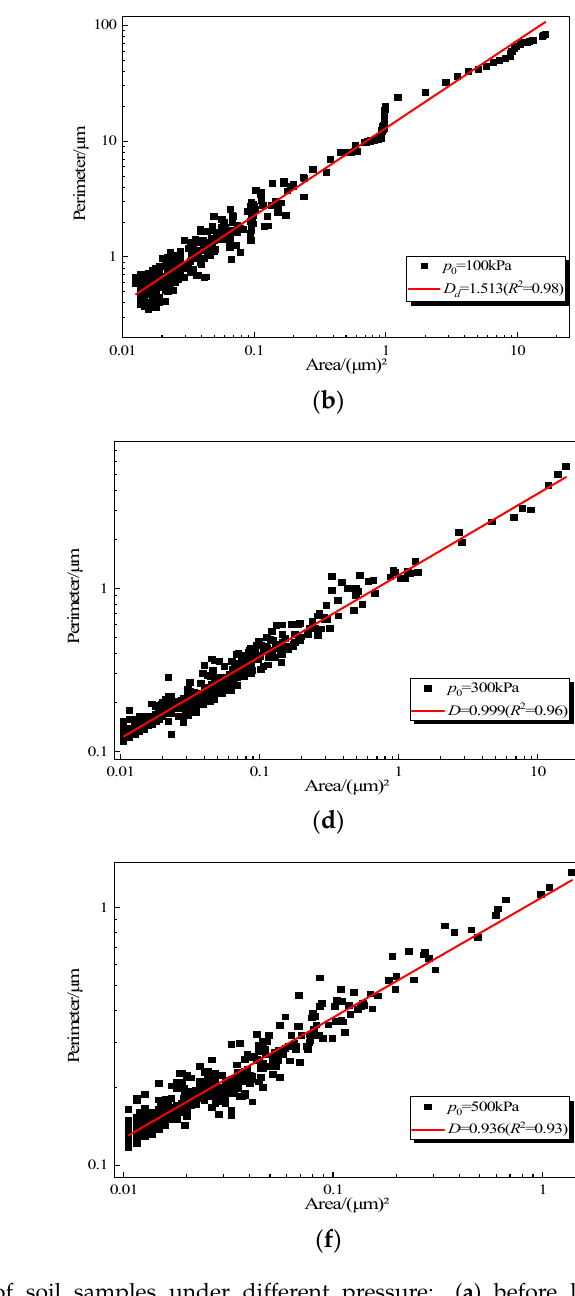
Figure 6. Fractal dimension of soil samples under different pressure: ( a ) before loading; ( b ) p 0 = 100 kPa; ( c ) p 0 = 200 kPa; ( d ) p 0 = 300 kPa; ( e ) p 0 = 400 kPa; ( f ) p 0 = 500